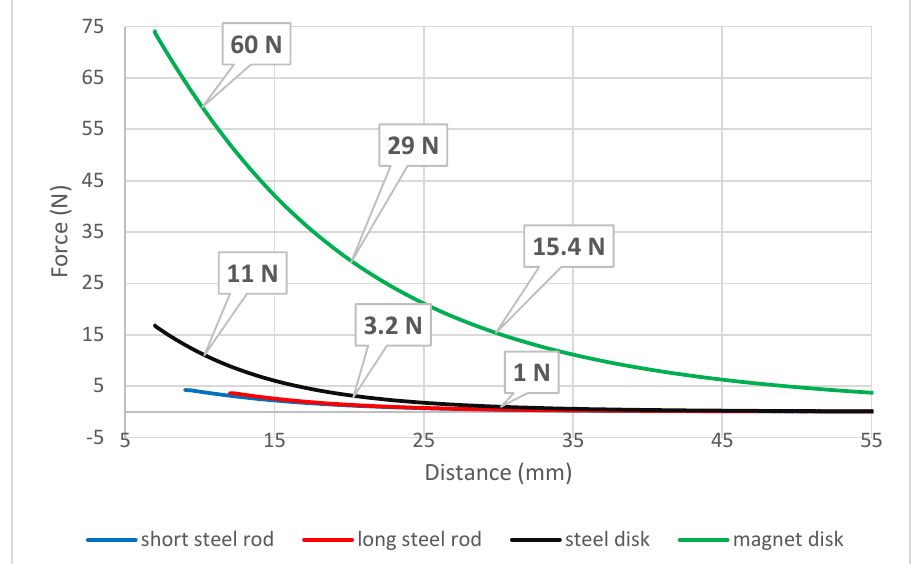
Figure 9. Force curves produced by varying the distance between a 45 kg pull-force neodymium magnet and a target specimen of a short steel rod, a long steel rod, a steel disk, and a disk magnet, as introduced in Figure 7. Our experiment setup was validated through these measurements to confirm the basic outcome.